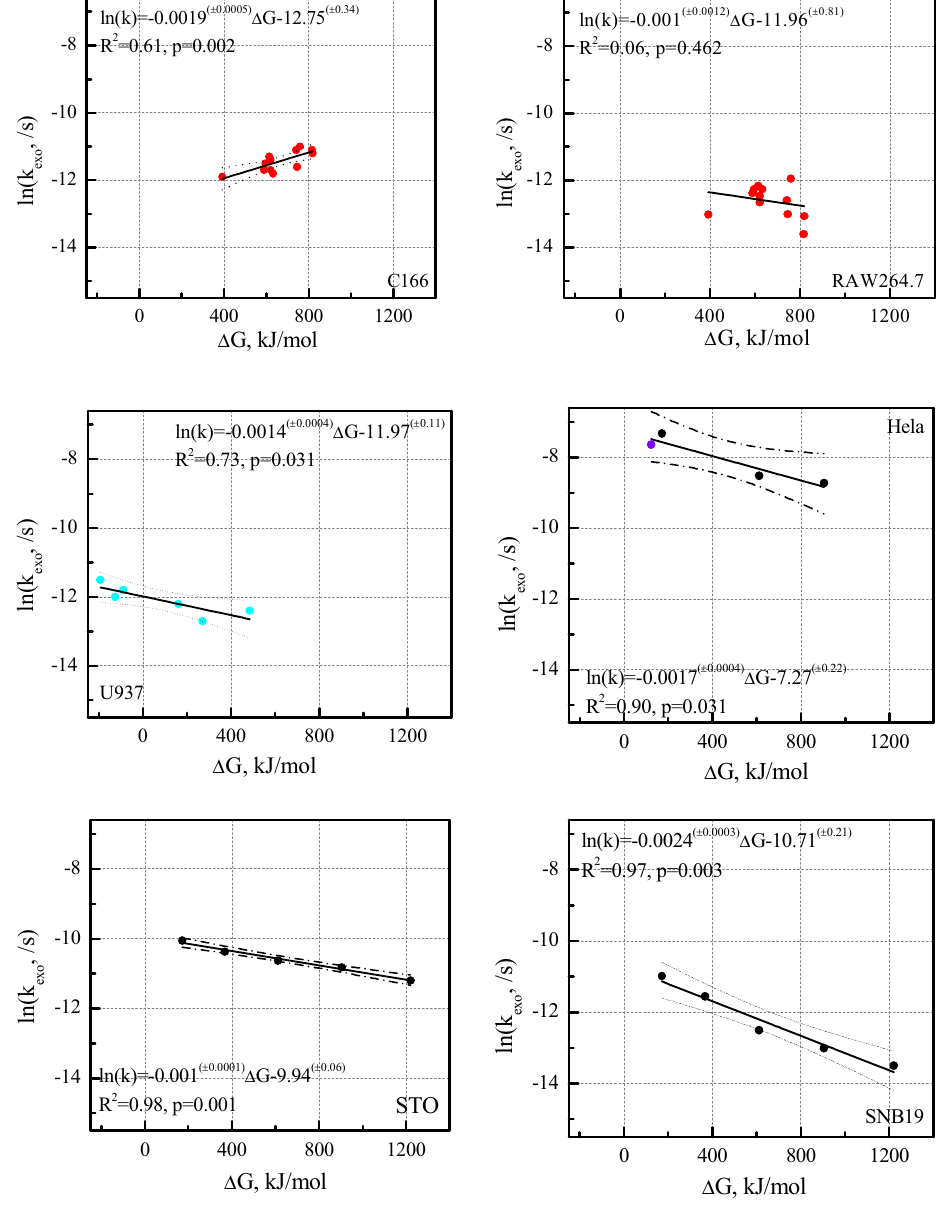
Figure 2. The exocytosis rate constant ln( k exo ) (/s) vs Δ G(d) (Eq. 6, kJ/mol) for six cell lines (C166 and RAW264.7 (12 neutral NPs with similar sizes and different coatings, are denoted by ‘red circle’ 43 . All k exo were obtained based solely on initial and final intracellular NP concentrations, Table S1); U937 (three zwitterionic and three PEG-coated NPs with different sizes, are denoted by ‘blue circle’ 44 . All k exo were obtained based on exocytosis curves, Fig. S2); Hela (three transferrin-coated NPs with different sizes, are denoted by ‘black circle’ 28 and one D-penicillamine coated NP, is denoted by ‘purple circle’ 45 . All four k exo were obtained based on exocytosis curves, Fig. S2); STO and SNB19 cells (five transferrin-coated NPs with different sizes, are denoted by ‘black circle’ 28 . All 10 k exo were obtained based solely on initial and final intracellular NP concentrations, Table S1)). The dotted lines denote 95% conference intervals. Modelling results include linear functions, R 2 and p